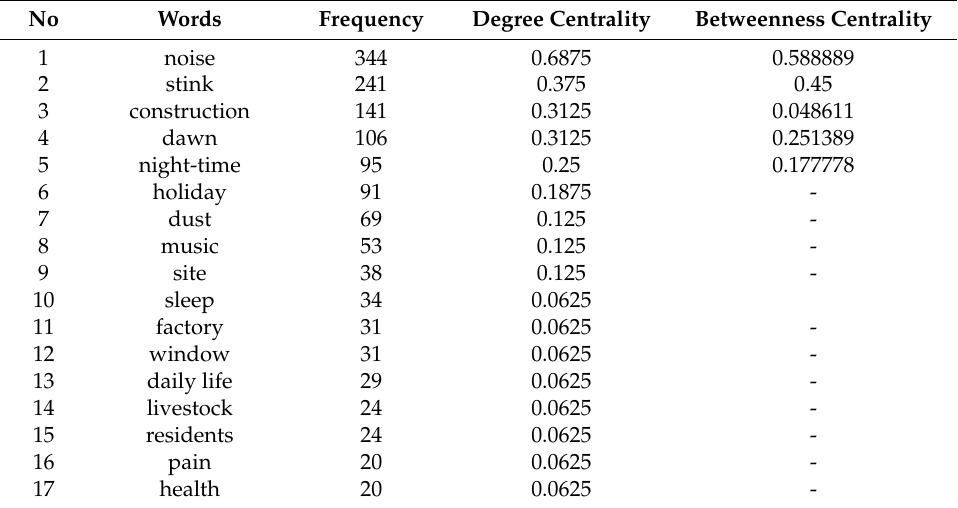
Table 2. The frequency and the centrality value of degree and betweenness of each word in 2014.